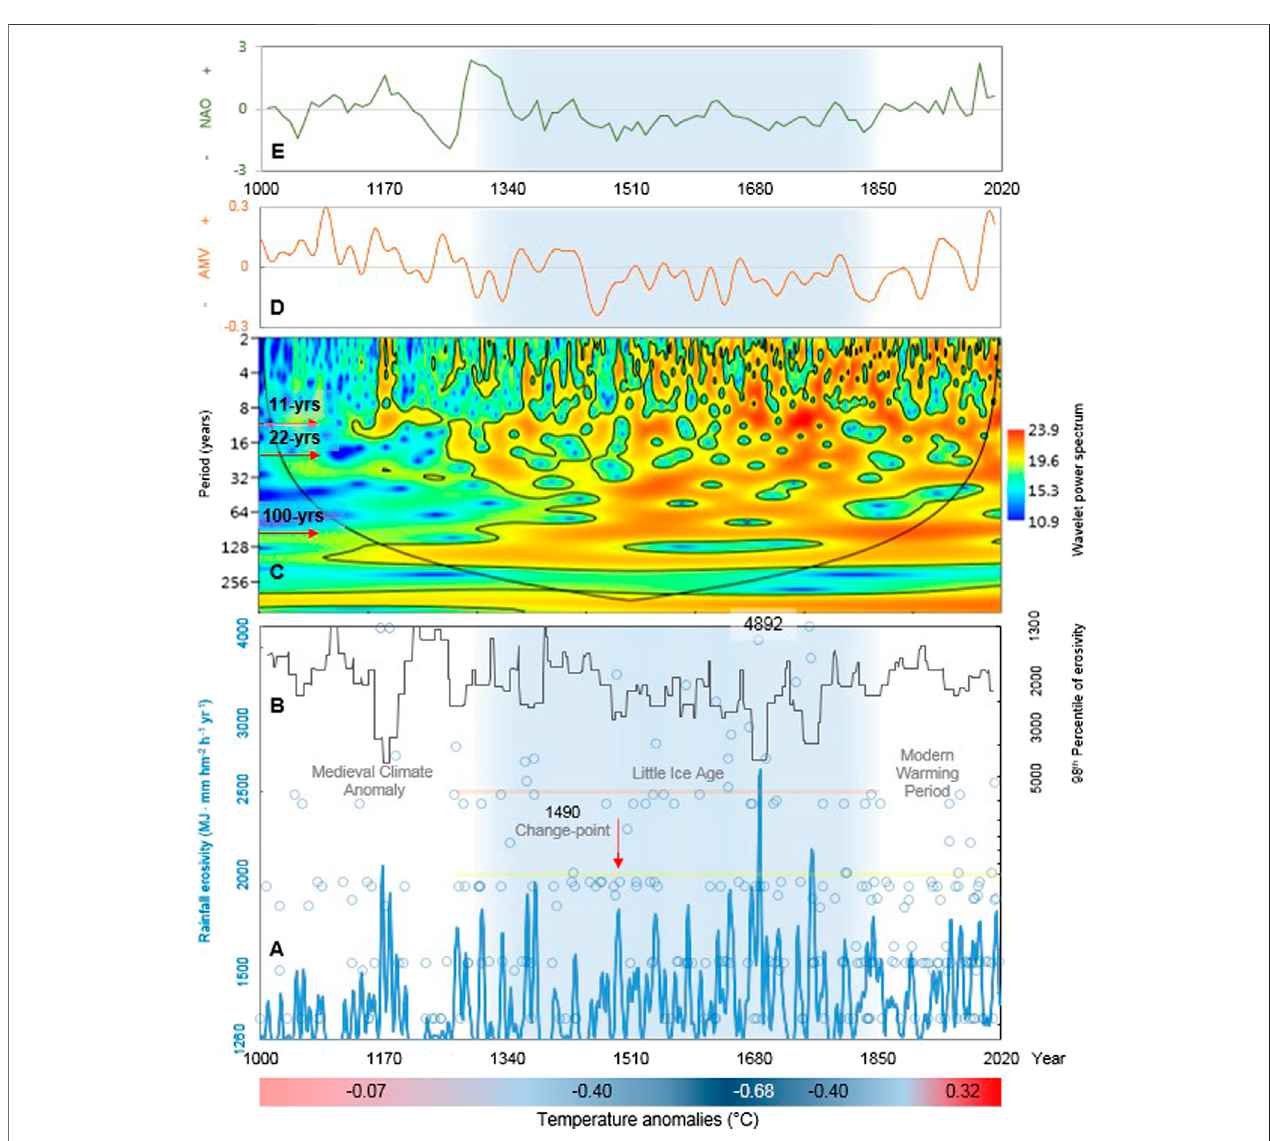
FIGURE 7| Overview oferosivity and climatic patterns over the period 1000 – 2019CE in the Arno River Basin. (A) Evolution (red arrow indicating the change-point year1490)ofestimatedannualrainfallerosivity(bluecircles;out-of-scalevalueintheyear1688)withtherelative95thand98thpercentiles(horizontalboldyellowandpink lines,respectively),andthe11-yearsGaussian fi lterederosivityseries(boldbluecurve), (B) decadal-scalevariabilityofthe98thpercentileofrainfallerosivity(blackcurve), (C) wavelet spectrum of the rainfall erosivity time series with bounded colors identifying 0.05 signi fi cance areas (the bell-shaped, black contour marks the limit between the reliable region and the region below the contour where the edge effects occur, a.k.a. cone of in fl uence), (D) Atlantic Multidecadal Variability (AMV; Wang et al., 2017), (E) North Atlantic Oscillation (NAO; Hernández et al., 2020). The bottom colored band indicates mean Italian summer (June-July-August) temperature anomalies( ° C)withrespecttothe1961 – 1990climatology(Luterbacheretal.,2016)fortheMedievalClimateAnomaly,threephasesoftheLittleIceAge(withindarkblue the years of the Maunder minimum) and the Modern Warming Period. The Little Ice Age is identi fi ed as a light blue area across the graphs A, B, D and E. The y -axex in A and B are